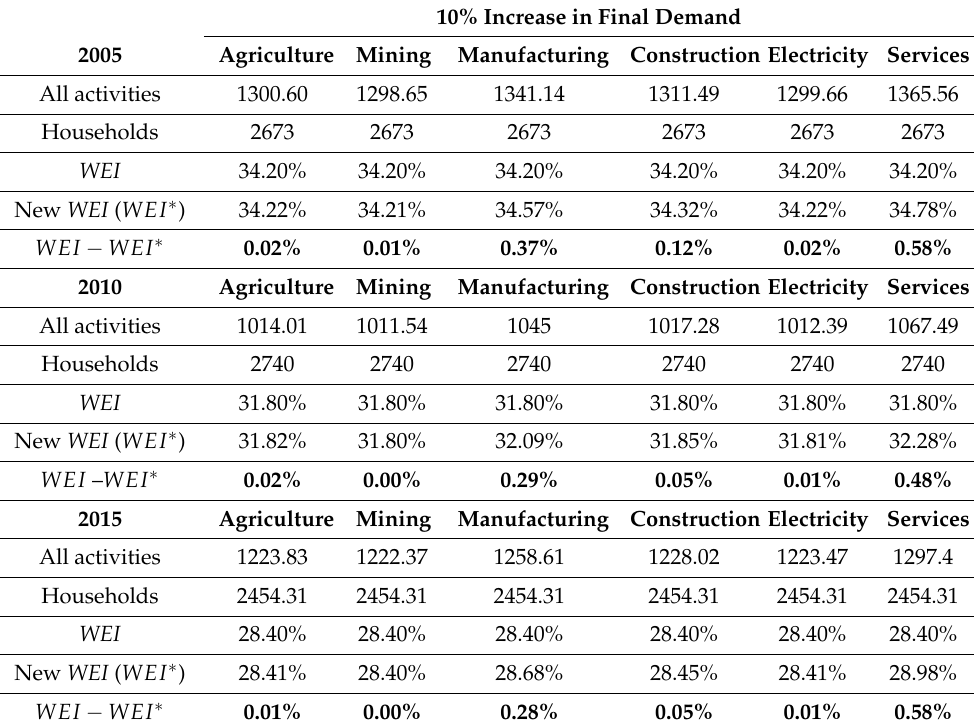
Table 6. Total water usage (hm 3 ) and the Water Exploitation Index ( WEI